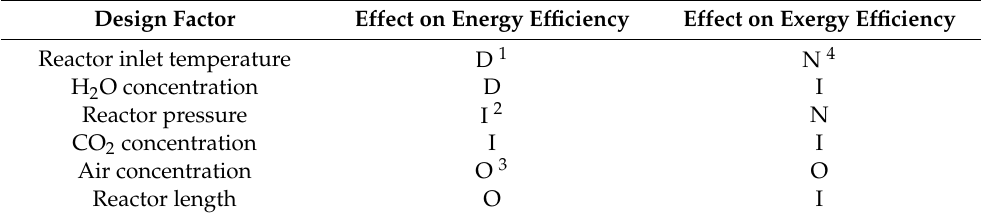
Table 7. Effect of different design factors on the energy and exergy efficiency of the system